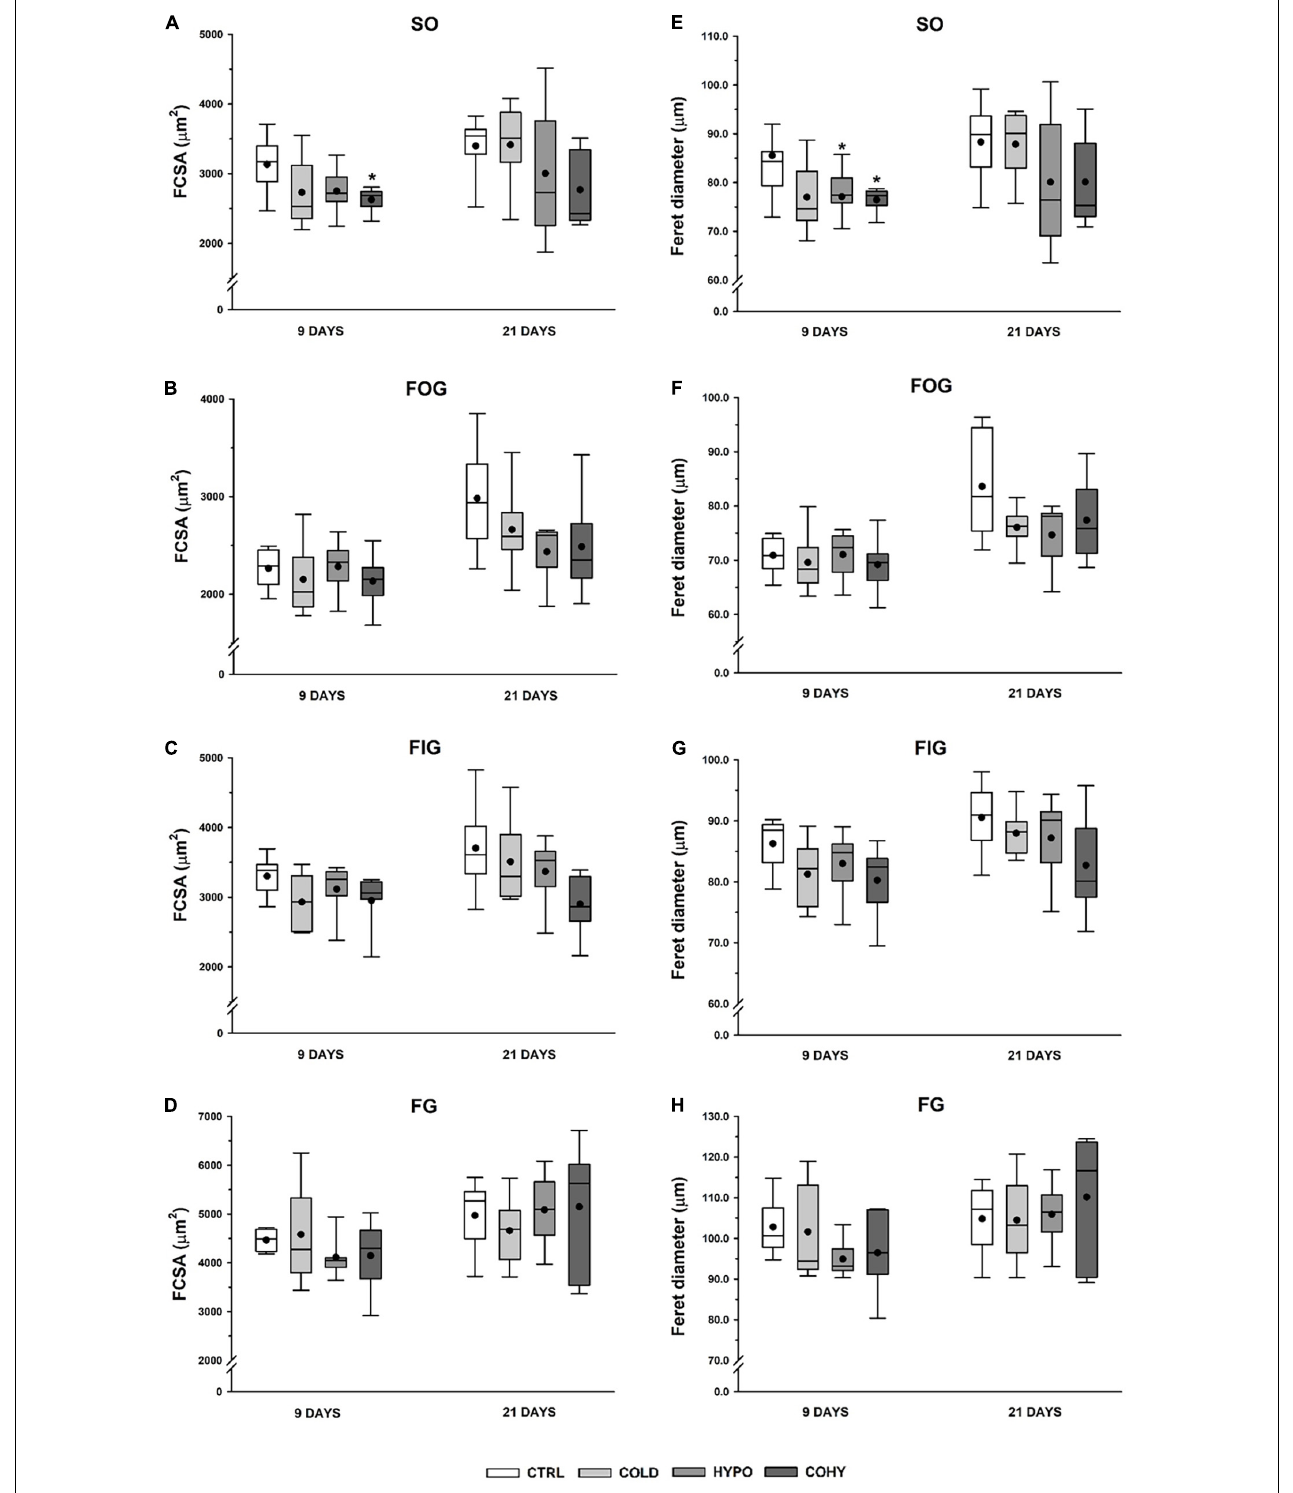
FIGURE 4 | Gastrocnemius muscle fiber morphometry after 9 and 21 days in the different fiber types. (A–D) Fiber cross-sectional area (FCSA), (E–H) Feret diameter. SO, slow oxidative; FOG, fast oxidative glycolytic; FIG, fast intermediate glycolytic; FG, fast glycolytic. CTRL, control; COLD, intermittent cold; HYPO, intermittent hypoxia; COHY, intermittent cold + hypoxia. Statistically significant differences are indicated as follows: * p < 0.05 vs. CTRL. Sample size: n = 6 per group at each temporal time point.